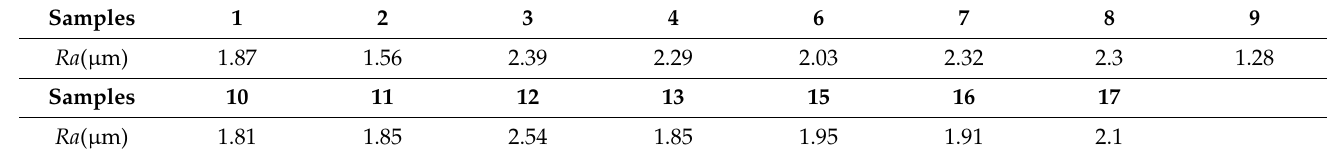
Table 6. Surface roughness Ra measurements of the test based on response surface